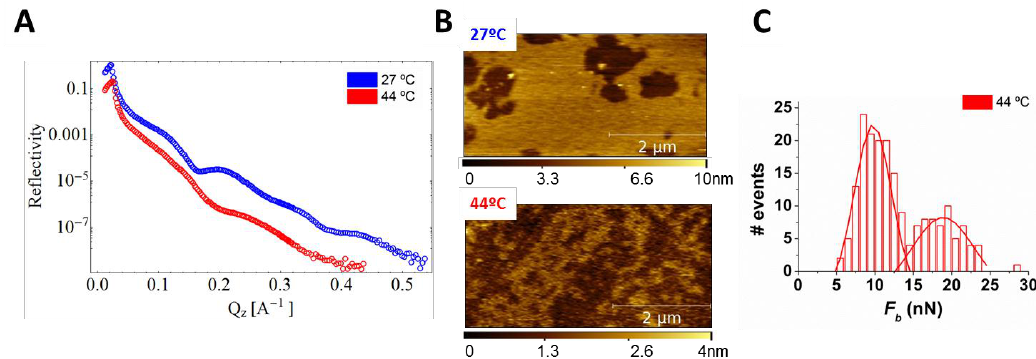
Figure 7. ( A ) XRR curves on DPPC bilayers at 27 °C ( blue ) and 44 °C ( red ); ( B ) AFM topographical images at 27 °C ( top ) and 44 °C ( bottom ); ( C ) F b histogram distribution for the DPPC SLB at 44 °C.